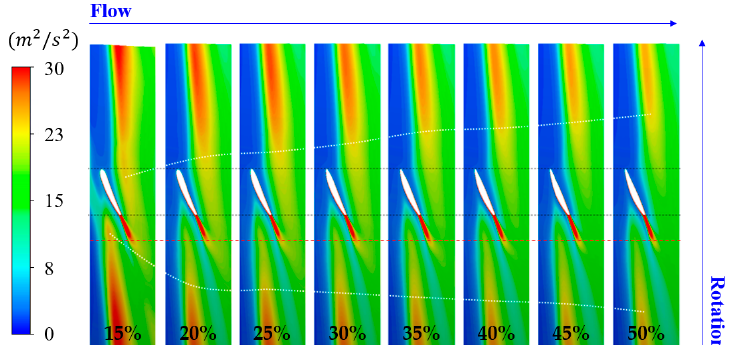
Figure 13. Distribution and range of turbulence kinetic energy near the shroud span with different maximum thickness positions ( 𝛷/𝛷 (cid:3031)(cid:3032)(cid:3046) = 1.0 ).